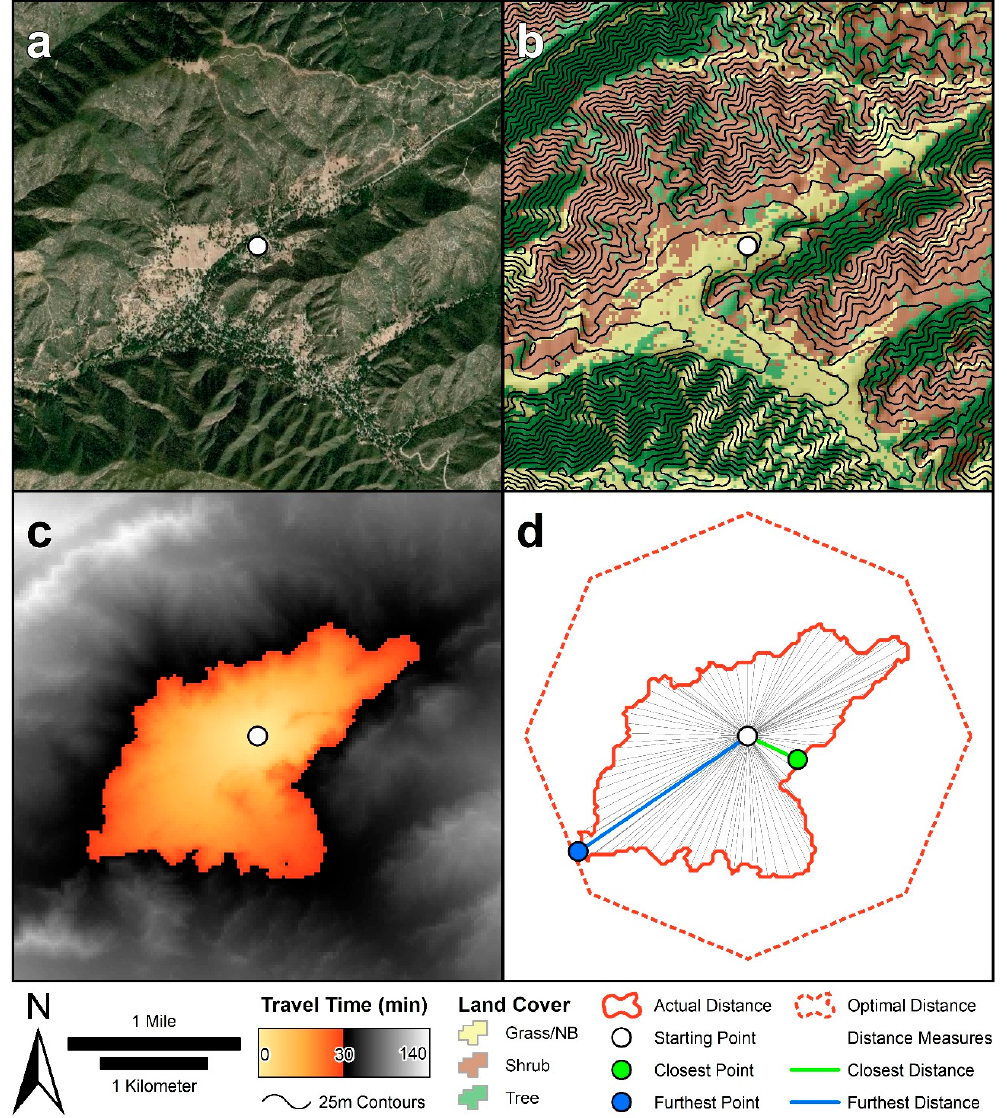
Figure 4. Spatial depiction of Escape Route Index (ERI) modeling technique: ( a ) sample starting point within the Angeles National Forest (ANF); ( b ) input spatial datasets for ERI calculation, including elevation and LANDFIRE-derived land cover; ( c ) accumulated travel time modeled from the starting point with a 30-min threshold applied; and ( d ) comparison of actual 30-min travel distance to optimal 30-min travel distance, with distance calculations. Table 5. Optimal travel distances for the three time frames.